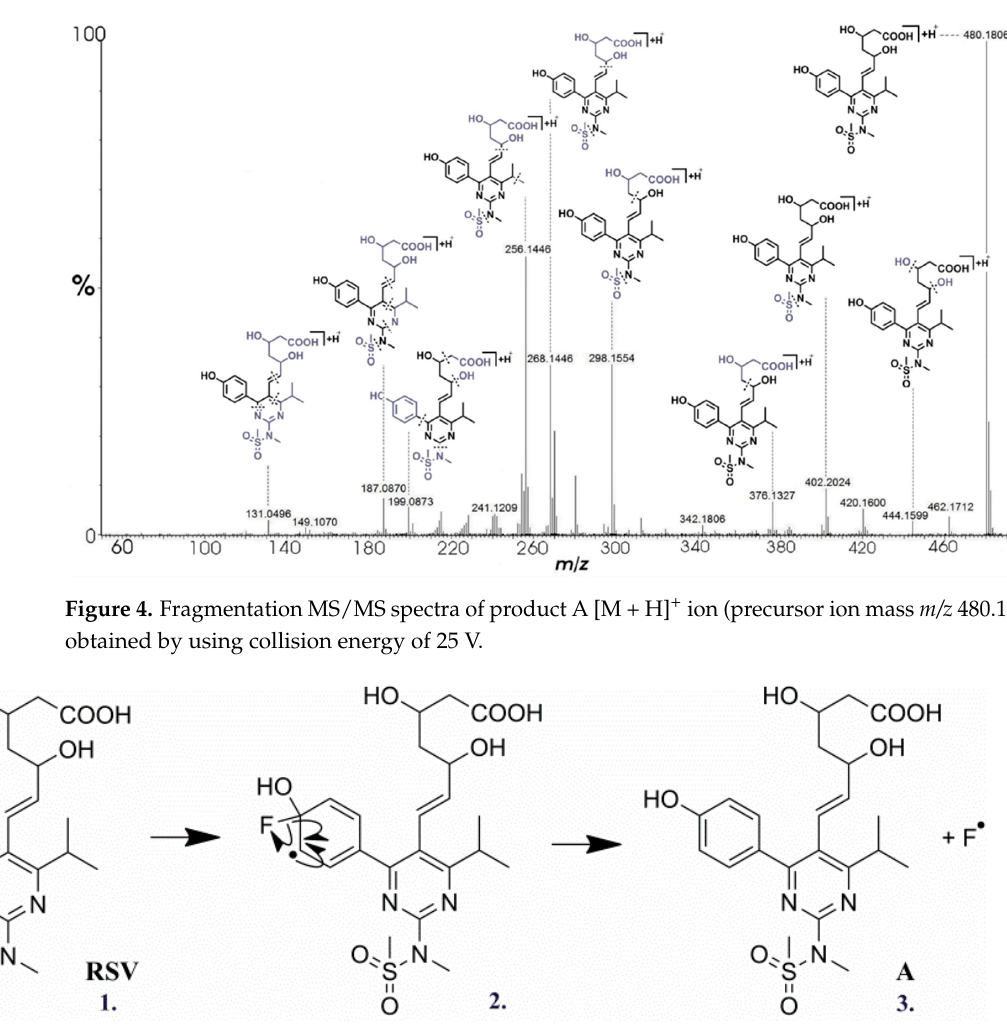
Scheme 1. Proposed mechanism of the compound A formation by radical substitution on RSV.